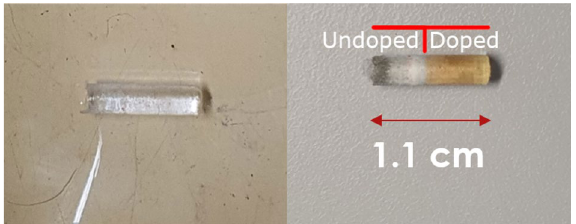
229 Figure 2. Th:CaF 2 single crystal grown with an activity of 1 MBq in the starting material. On the left, the crystal as it was inspected immediately after growth. On the right, the crystal after 3 days. The orange coloring is due to radioactivity-induced agglomerations of defects (F-centers) 21 . The melting boundary can be clearly seen in the color difference, the doped and undoped sides are indicated. The top of the crystal is on the right.